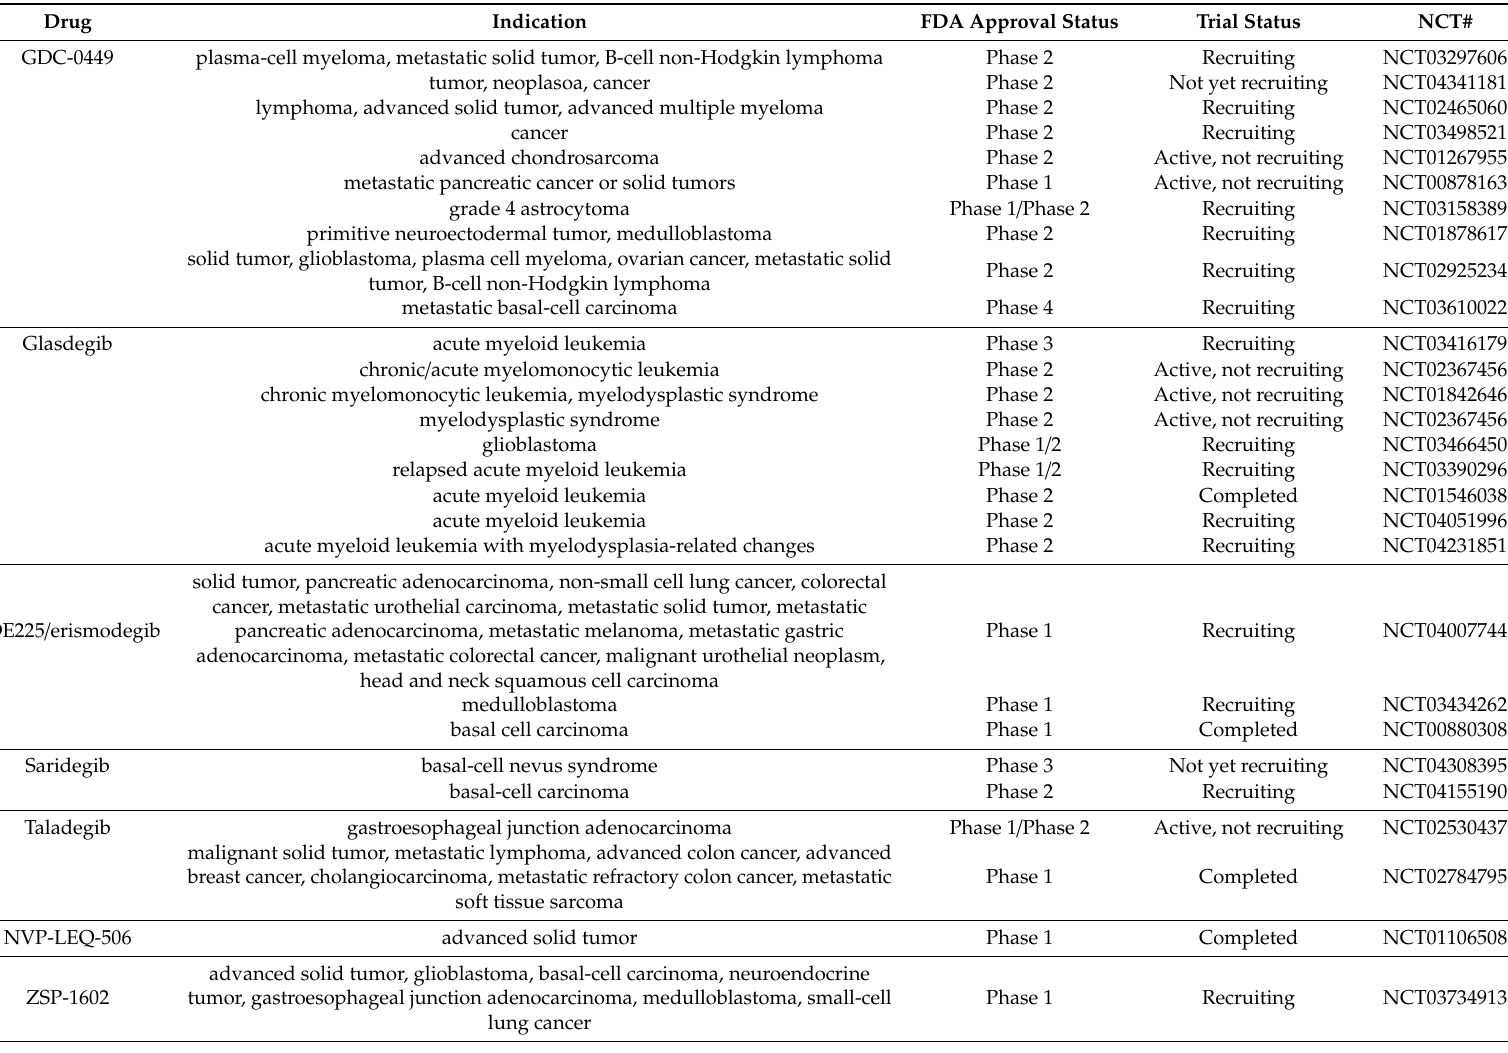
Table 2. SMO drug in clinical trials (last updated in 2020,